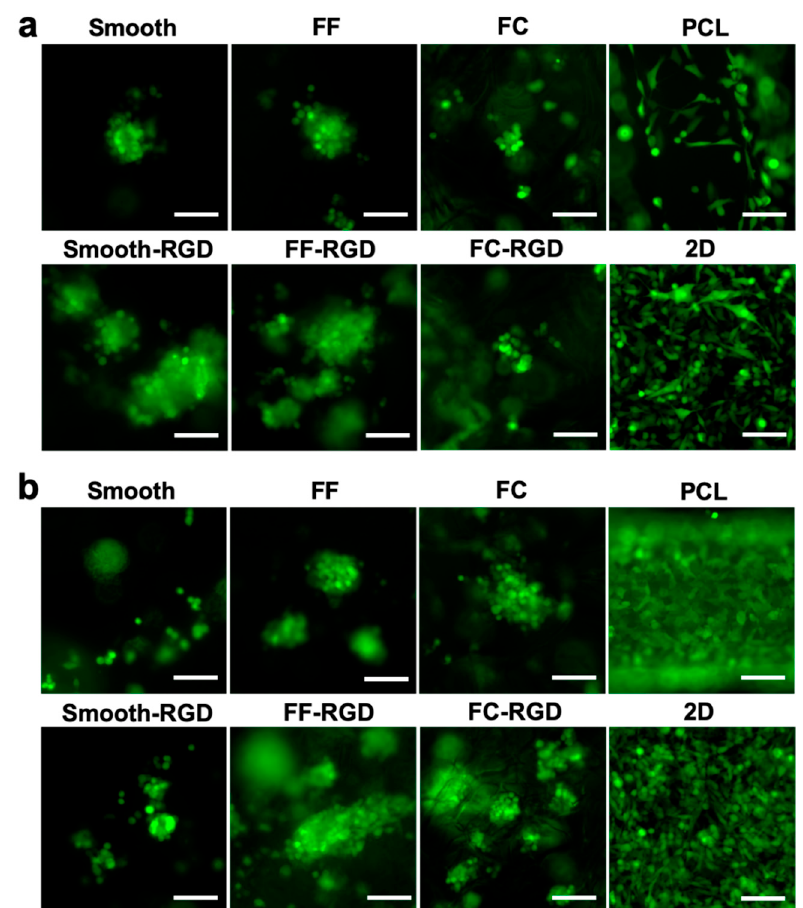
Figure 10. MDA-MB-231 cell morphology on FF scaffolds. Fluorescence images of smooth, FF, FC, and PCL scaffolds and 2D surfaces at 3 d ( a ) and 7 d ( b ). Scale bars are 100 μ m.